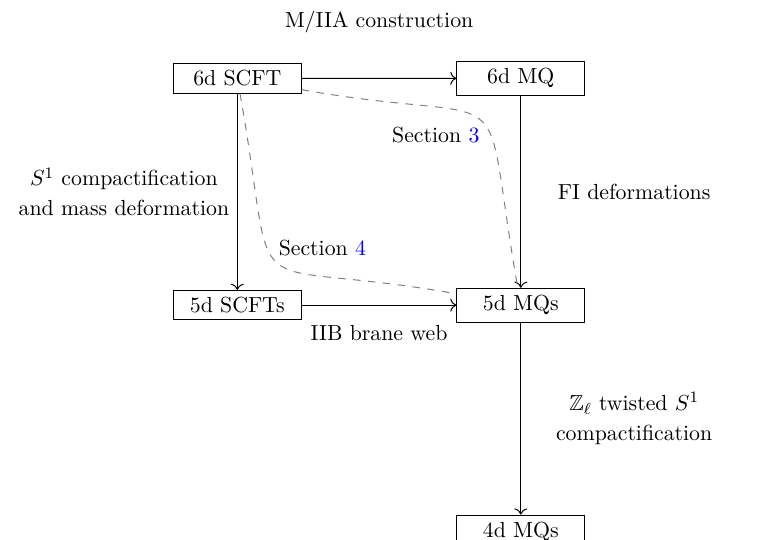
Figure 1. Summary of the derivations of the 4d magnetic quivers discussed in sections 3 and 4.